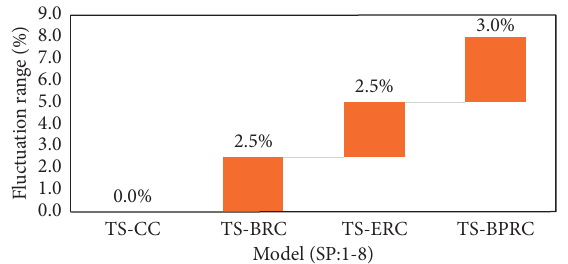
Figure 12: Service level fluctuation in different